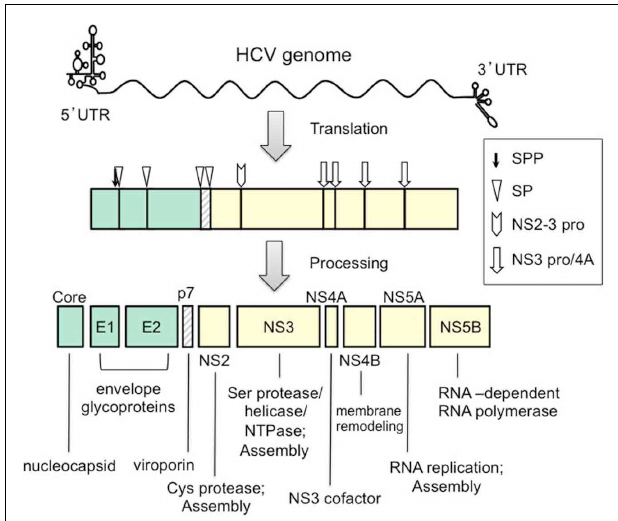
FIGURE 1 |The HCV genome and polyprotein. The RNA genome comprises a 9.6-kb RNA of plus strand polarity. Post-translational cleavages by SPP (signal peptide peptidase), SP (signal peptidase), NS2-3 pro (NS2–NS3 cysteine protease), and NS3 pro/4A (NS3 serine protease and NS4A complex) lead to the production of functional HCV proteins. Functions of each protein in the viral lifecycle are indicated below the open reading